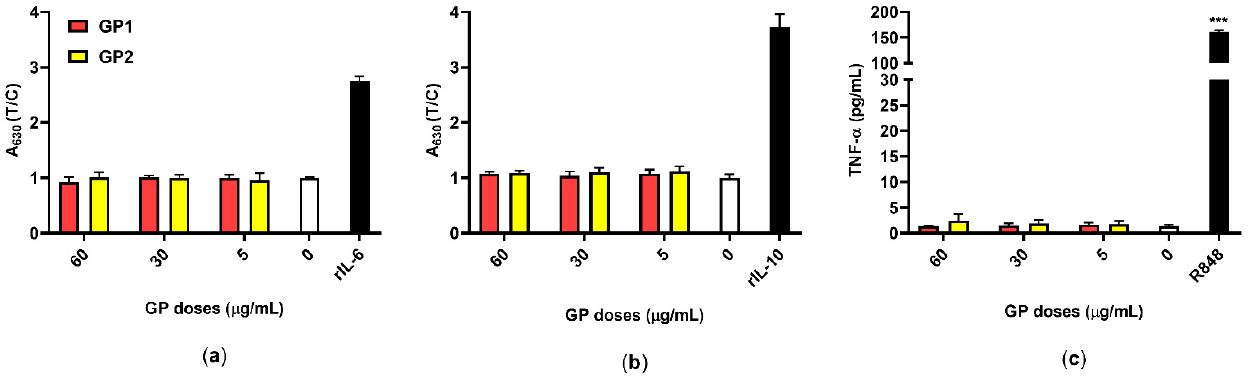
Figure 7. Inflammatory responses of THP-1 in response to GP (T; 5–60 µ g/mL) compared to untreated control (0 µ g/mL). ( a ) The release of IL-6 was measured using the reporter HEK-Blue™ IL-6 cells ELISA, rIL-6 (3 ng/mL) was used as an assay control; ( b ) the release of IL-10 was measured using the reporter HEK-Blue™ IL-10 cells, rIL-10 (10 ng/mL) was used as an assay control. Data are normalized to the control (0 µ g/mL) and are presented as mean ± standard deviation; ( c ) the release of TNF- α was measured using ELISA, and R848 (10 µ M) served as a positive control. Data are presented as mean ± standard deviation. *** p -value < 0.001.